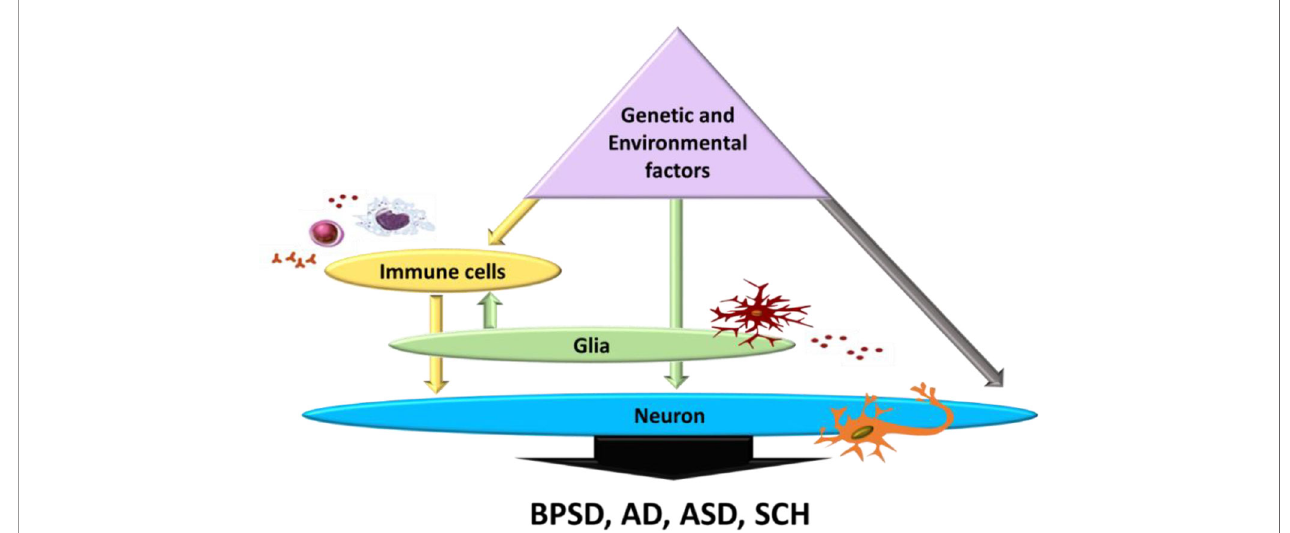
FIGURE 2 | Effect of genetic and environmental factors on neuronal dysfunction and immune response modulating BPSD, AD, ASD, and SCH symptoms. All possibilities contributing to ASD through glia activation (grey arrow), or through directly altering peripheral immune cells (white arrows) which in turn activates glia affecting the neuronal function (black arrows). BPSD, Behavioral and Psychological Symptoms of Dementia; AD, Alzheimer ’ s disease; ASD, Autism Spectrum Disorder; SCH, Schizophrenia. Adapted from (Depino, 2013).